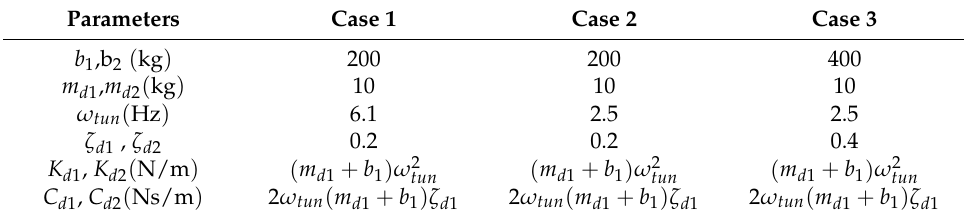
Table 3. Chosen parameters for the TMDIs in different cases.